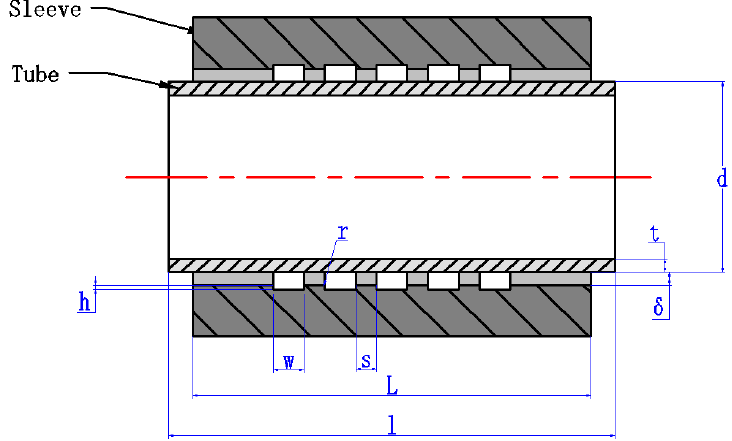
Figure 1. Principle of EMP connection technology for pipe joints.